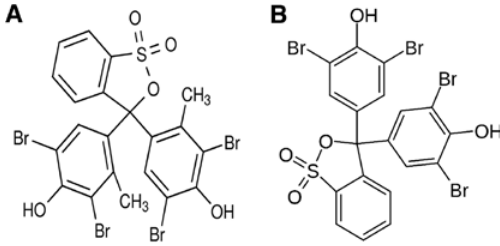
Figure 4: Chemical structures: (A) bromocresol green and (B) bromophenol